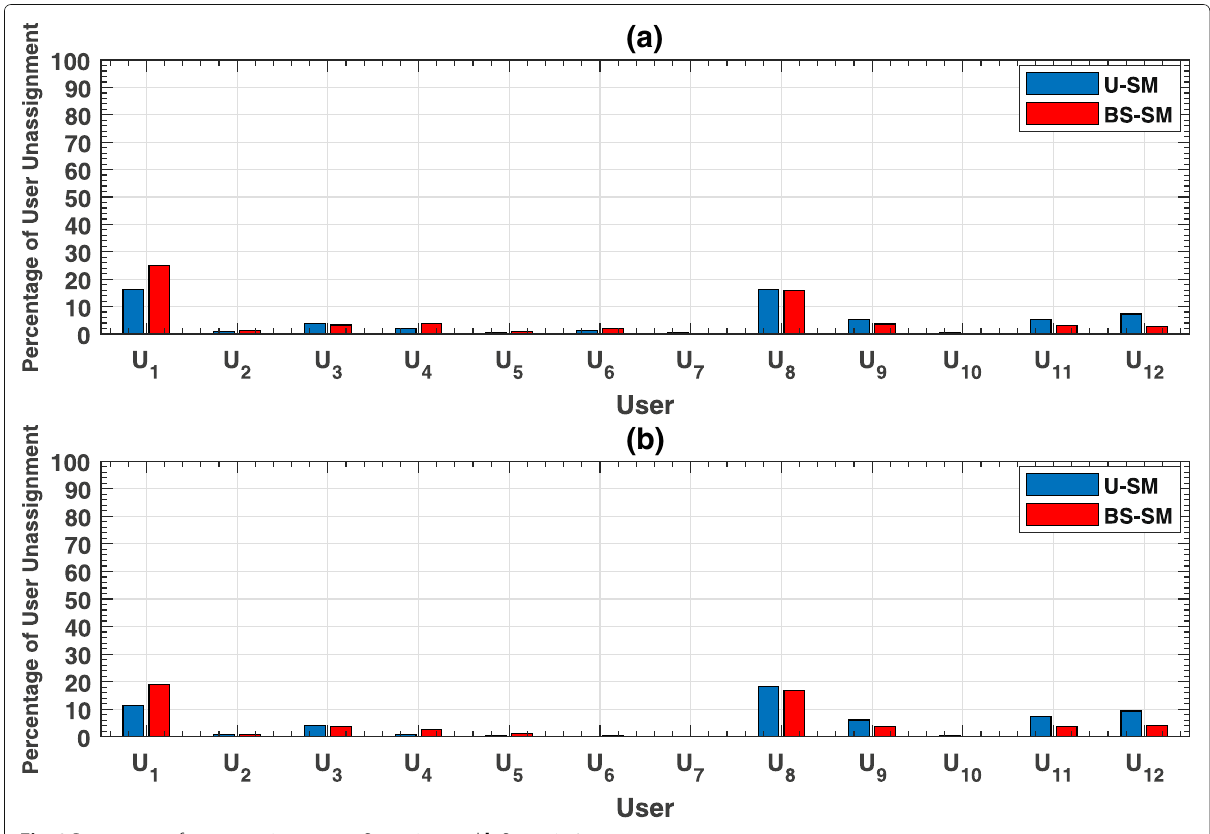
Fig. 8 Percentage of user unassignment: a Scenario 1 and b Scenario 2